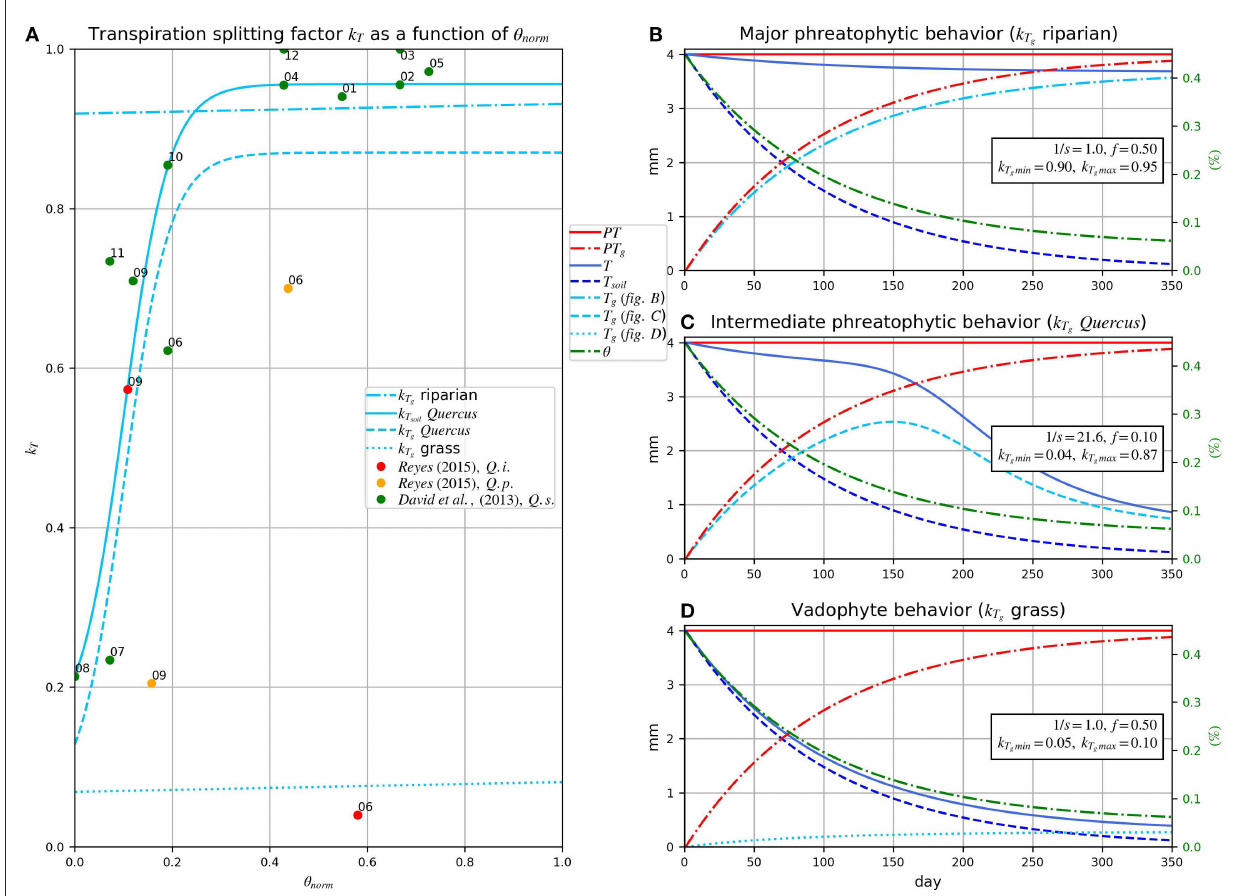
as and k T g soil of three tree species ( Q . i ., Quercus ilex ; Q . p ., Quercus soil and k T representing riparian, phreatophytic and g min g max